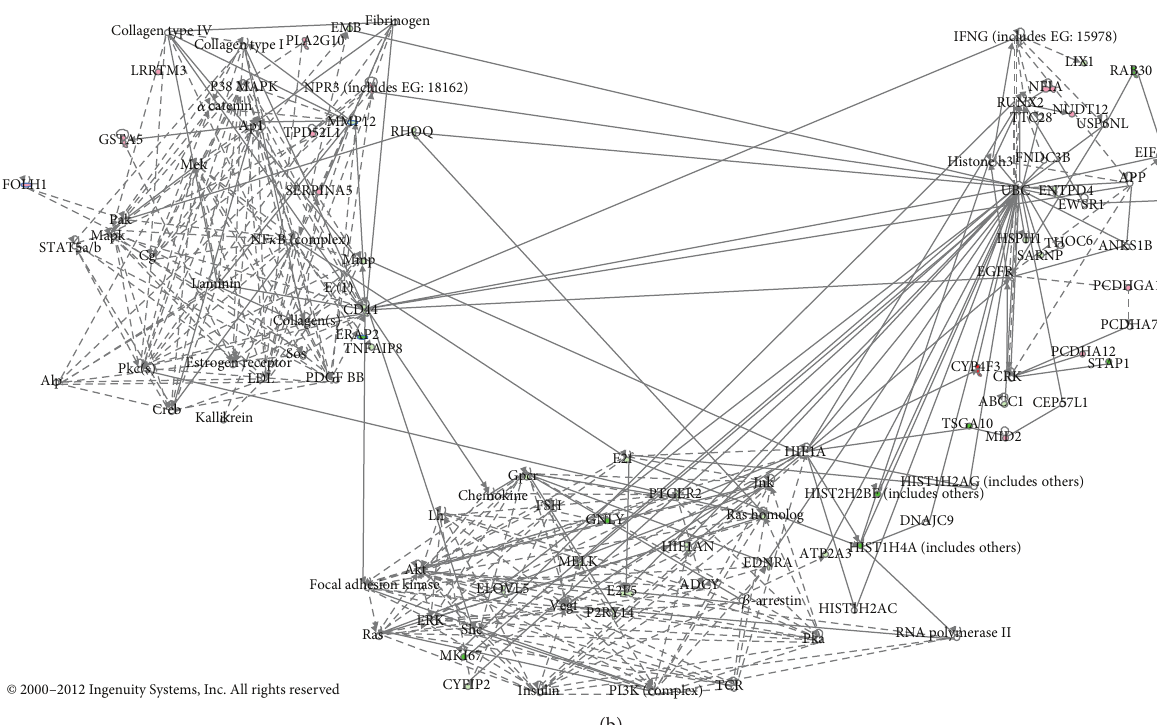
Figure 3: IPA network illustration of the relationships among gene groups showing significantly increased/decreased expression in the presence of IPH. Genes colored pink or red exhibited increased expression, while genes colored green exhibited reduced expression. The straight lines indicate direct relationships among genes, while broken lines indicate indirect relationships. (a) Illustration of the first selected pathway combined with the second pathway. (b) Illustration of the first pathway combined with the third and fifth pathways. Similar to the results from Ingenuity iReport analysis, reduced expression of ENTPD4, ABCC1, ADA, and TGF- 𝛽 and increased expression of CYP4F3 were observed inside the IPA